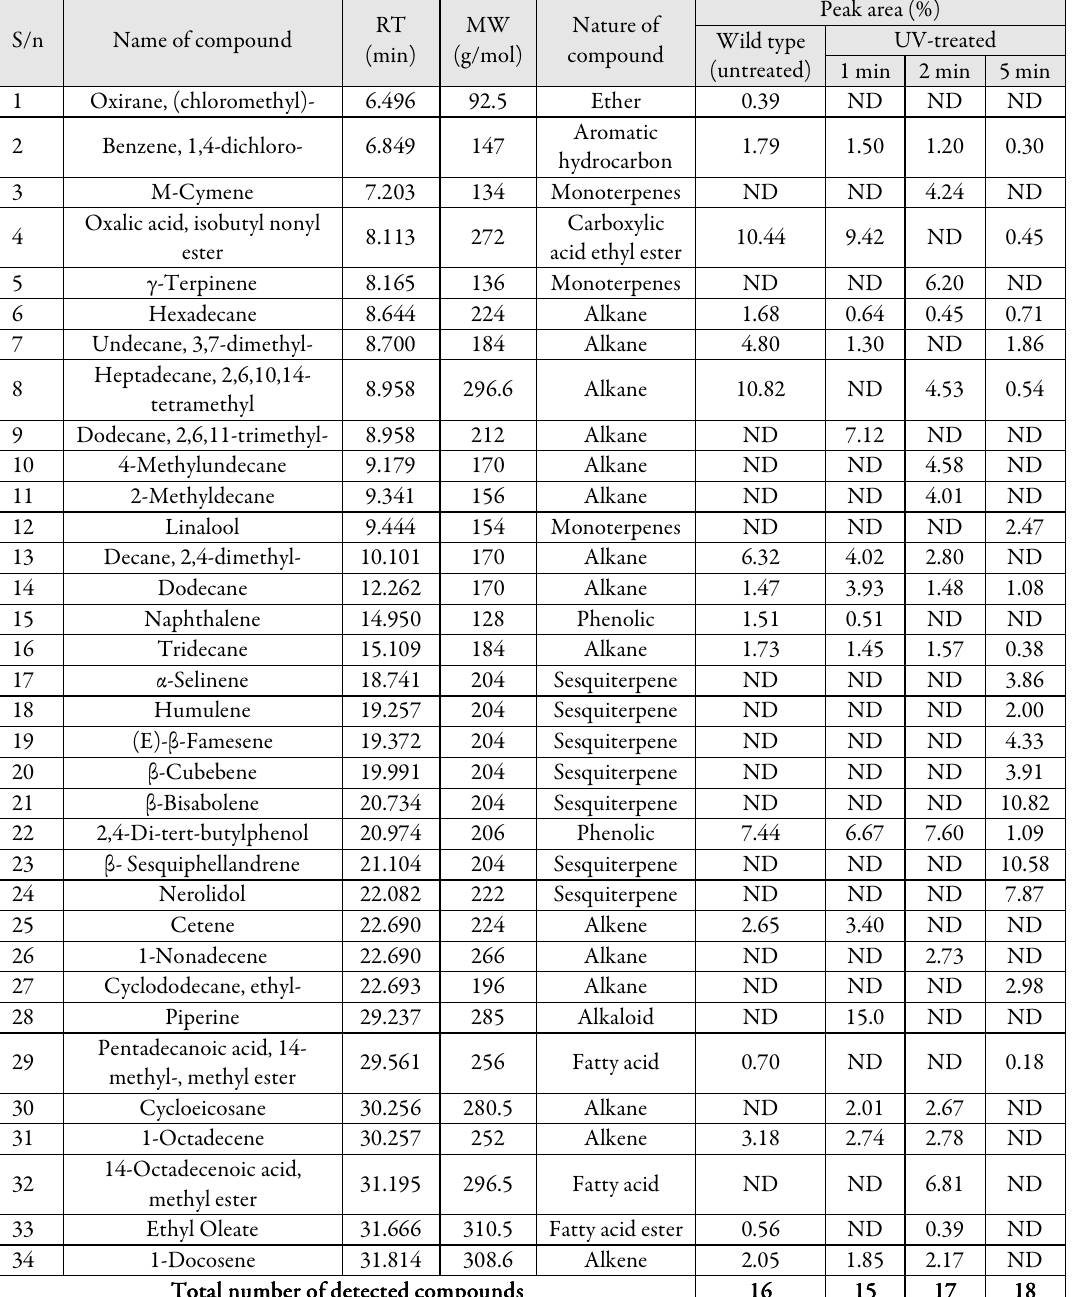
Table 2. Comparison of the GC-MS identified compounds in the wild type L. theobromae and UV-treated L. theobromae